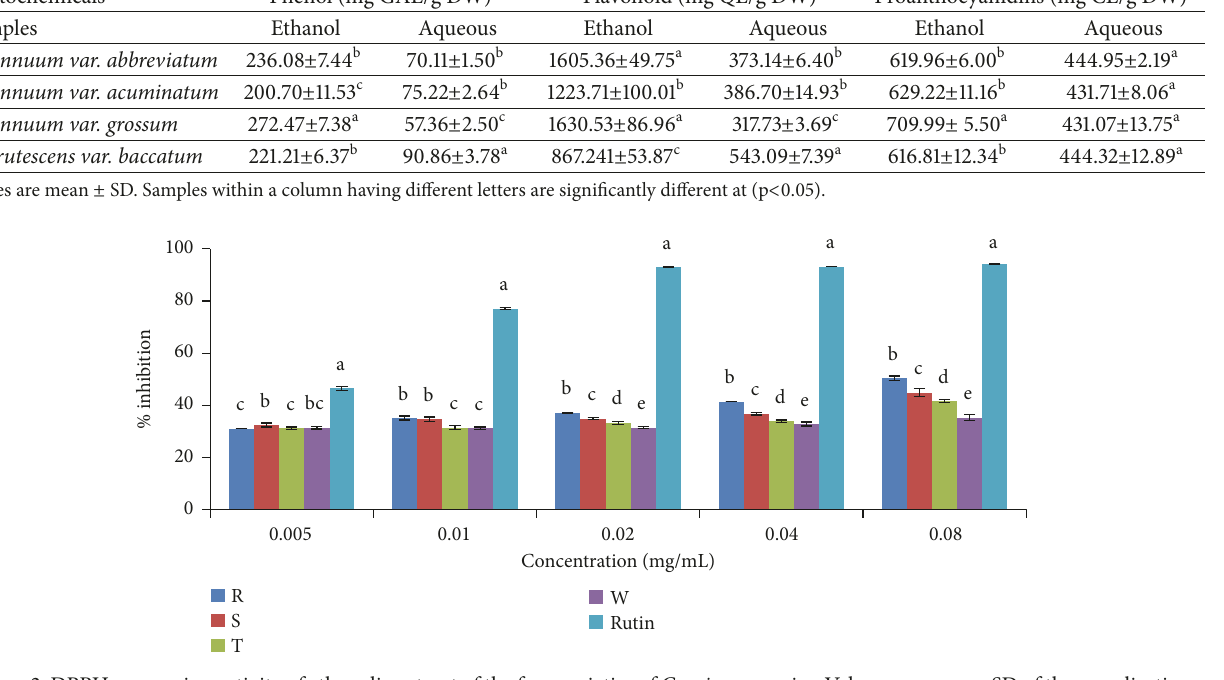
Figure 2: DPPH scavenging activity of ethanolic extract of the four varieties of Capsicum species. Values are mean ± SD of three replications. Set of bars having different letters are significantly different at (p < 0.05). R= C. annuum var. abbreviatum , S= C. annuum var. acuminatum ,